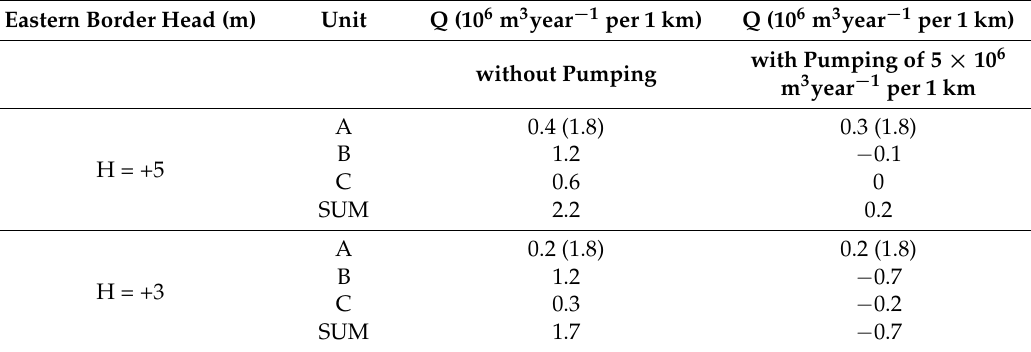
Table 6. Calculated flux to the sea with and without pumping from the coastal aquifer. In brackets, is the flux from unit A affected by ponds losses. The natural discharge to the sea is about 2.2 m 3 year − 1 per 1 km.